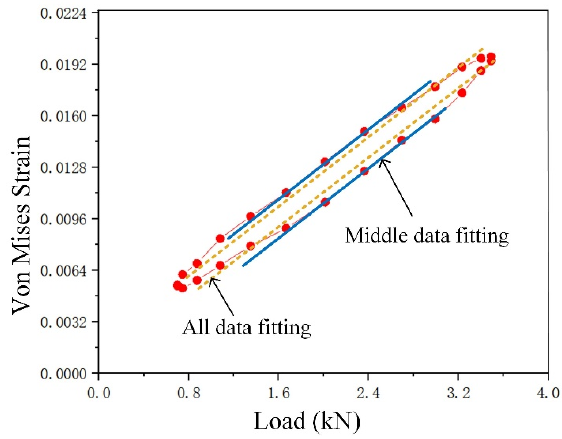
Figure 13. Fitting result of straight-line segment of load–strain loop curve.